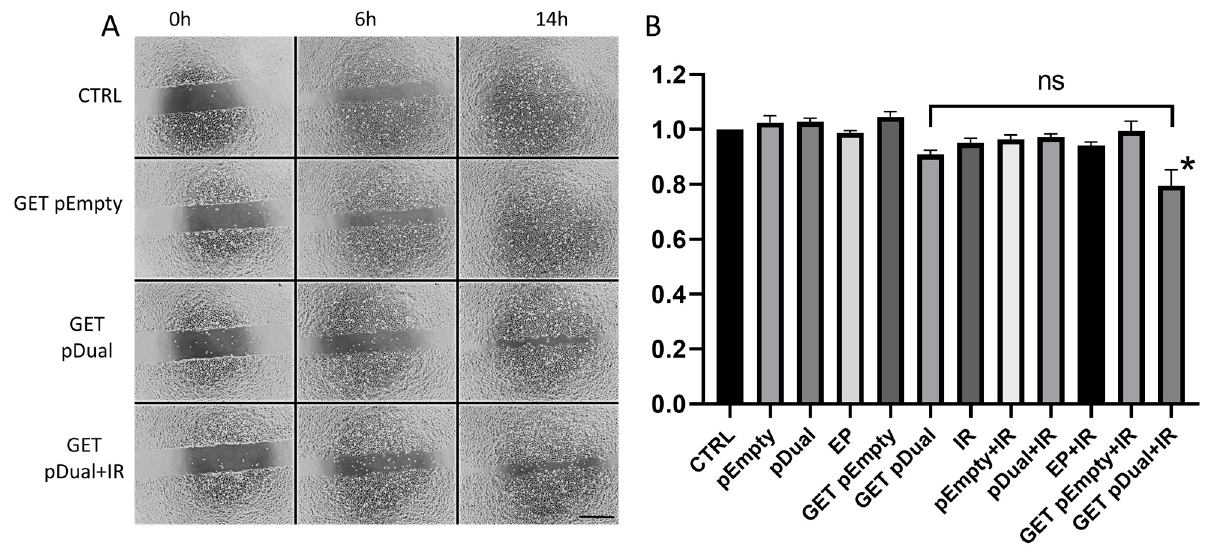
Figure 4. The effect of pU6-anti-CD105-146-ORT GET alone or in combination with IR on endothelial cell migration. ( A ) Representative images 2H-11 gap filling 6 and 14 h after pU6-anti-CD105-146-ORT GET and IR. ( B ) Results of the kinetic analysis of 2H-11 cell migration after pU6-anti-CD105-146-ORT GET and IR. Bars represent the mean ± standard error of mean for three independent experiments. Values are normalized to the control group. *, statistically significant difference vs. all groups ( p < 0.05). ns, statistically non-significant difference. Scale bar = 500 µm. Group names: CTRL—untreated cells, pEmpty—treatment with pEmpty-ORT plasmid alone, pDual—treatment with pU6-anti-CD105-146-ORT plasmid alone, EP—application of electric pulses alone, GET pEmpty—GET of pEmpty-ORT plasmid, GET pDual—GET of pU6-anti-CD105-146-ORT plasmid, IR—IR with 5 Gy, EP + IR—application EP and IR with 5 Gy, GET pEmpty + IR—GET of pEmpty-ORT plasmid and IR with 5 Gy, pDual + IR—GET of pU6-anti-CD105-146-ORT plasmid and IR with 5 Gy.